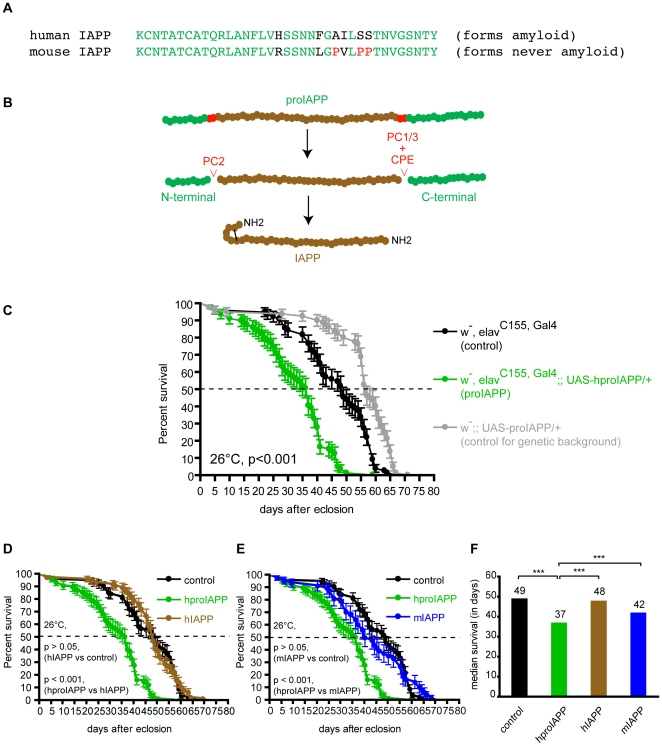
One letter code for human and mouse IAPP residues 1–37.Amino acid identity is shown in green and residue substitutions are shown in black, except for the three proline residues substitutions present in mouse IAPP that are shown in red (A). Proline residues are known beta-breakers and it is believed that these residues hinder IAPP-aggregation. ProIAPP processing. In man, proIAPP is synthesised as a 67 residue long polypeptide that undergoes posttranslational cleavage at dibasic residues (red) performed by the prohormone convertases PC2 and PC1/3. The two basic residues that remain at the C-terminus after PC1/3 processing are removed by carboxypeptidase E. Thereafter, the remaining C-terminal glycine residue is used for C-terminal amidation. A disulphide-bond is formed between residues 2 and 7 (B). Survival curve for flies expressing hproIAPP shows a reduction in life span. Expression of proIAPP was directed to neurons by the elavC155,Gal4 driver (C). This expression resulted in a significant reduction of lifespan (green), when compared to control flies (elavC155,Gal4, black) or flies containing UAS-proIAPP only (grey). These latter flies contain the inserted DNA, but do not express the corresponding protein due to absence of Gal4. (D) Comparison of the survival of hIAPP (brown) and elav C155,Gal4, (black) expressing flies shows that hIAPP expression does not reduce the survival (p>0.05). The hproIAPP (green) expressing flies showed a significant shorter lifespan than hIAPP (brown, p<0.001). (E) Comparison of the survival of mIAPP (blue) with control flies elavC155, Gal4, (black) showed that mIAPP expression does not reduce the survival of the flies (p>0.05). Flies expressing mIAPP (blue) lived longer than hproIAPP expressing flies (green, p<0.001). (F) The median survival for control flies (black), hproIAPP (green), hIAPP (brown) and mIAPP (blue) are 49, 37, 48 and 42 days, respectively, and the survival of hproIAPP flies is significantly reduced when compared to flies from the control, hIAPP and mIAPP strains (p<0.001).The survival for hIAPP flies is not reduced when compared to mIAPP or control flies. The survival studies were performed in an incubator with 70% humidity, at 26°C.